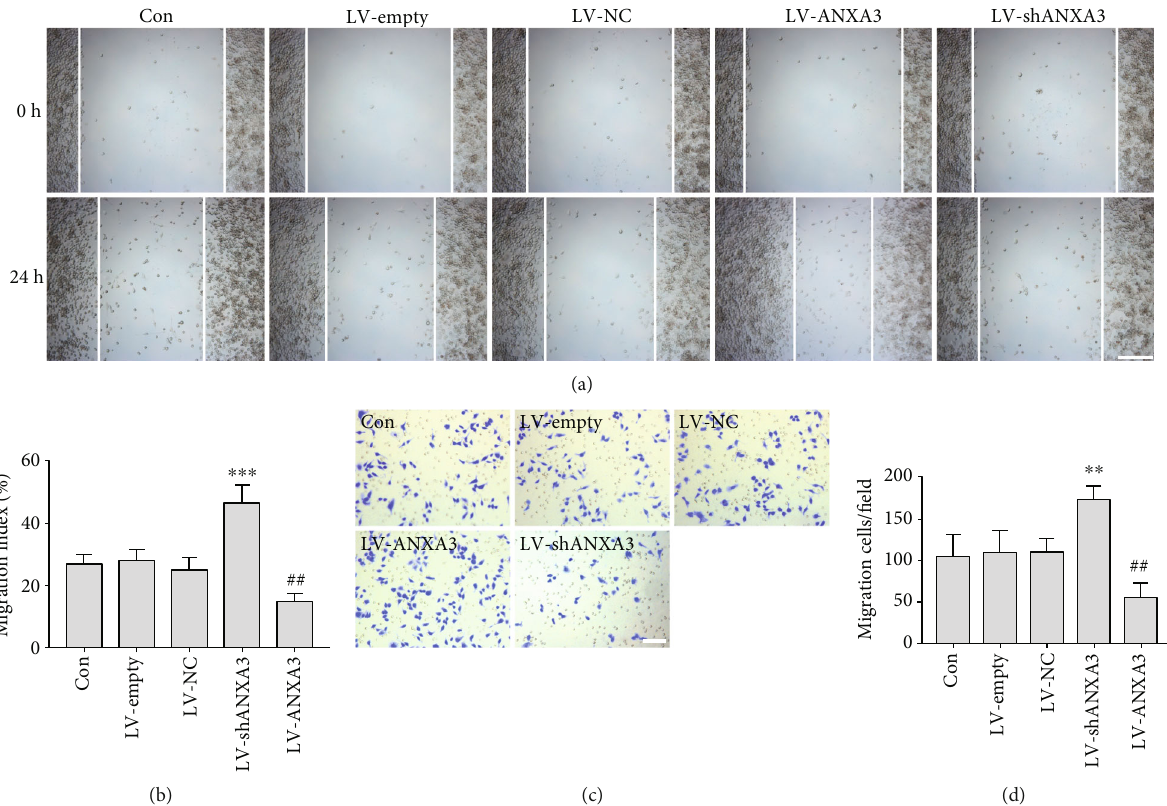
Figure 9: The migration of microglial N9 cells. (a, b) Evaluation of cell migration using a wound healing assay; monolayers were viewed on an inverted microscope. The histogram shows the quantitative analysis of the cell migration index. The data are expressed as the means ± SD and were analyzed by one-way ANOVA with Tukey ’ s post hoc test. ∗∗∗ p < 0 : 001 compared with the LV-empty group. ## p < 0 : 01 compared with the LV-NC group. The data were pooled from fi ve independent experiments. (c, d) Evaluation of cell migration using the Transwell assay; migratory cells were viewed under an inverted microscope. The histogram shows the quantitative analysis of migrating cells. The data are expressed as the means ± SD and were analyzed by one-way ANOVA with Tukey ’ s post hoc test. ∗∗ p < 0 : 01 compared with the LV-empty group. ## p < 0 : 01 compared with the LV-NC group. The data were pooled from fi ve independent